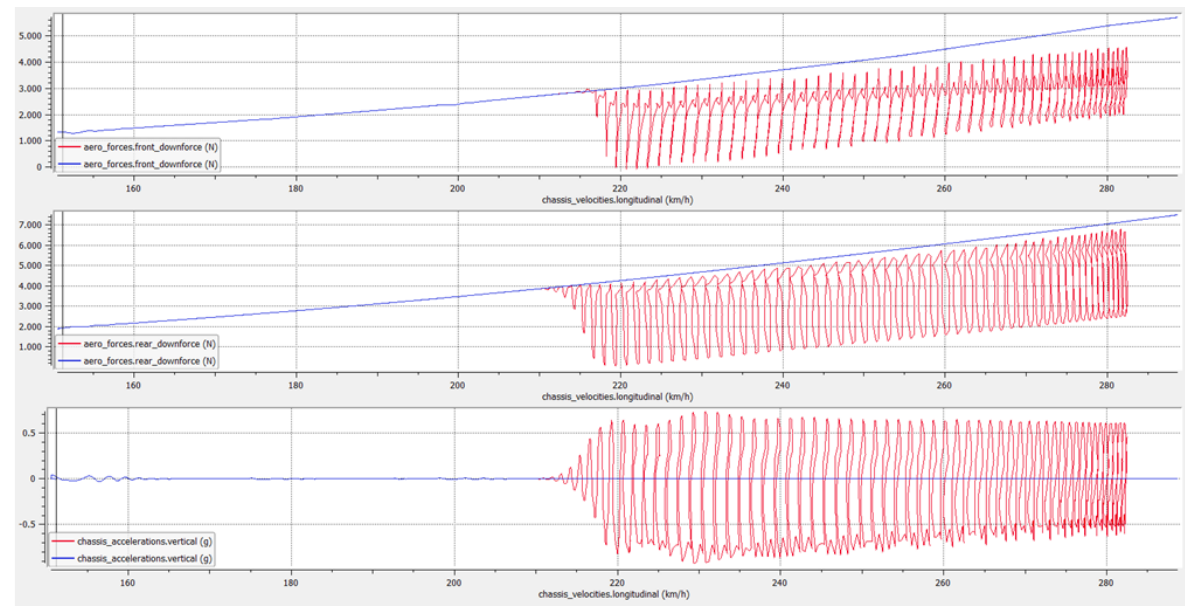
Figure 17. Comparison of aerodynamic vertical forces with baseline maps (blue) and with decay functions (red). Apart from the oscillations, the average downforce is massively reduced either at the front ( top plot) and at the rear ( middle plot). Vertical acceleration at the center of gravity ( bottom plot) oscillates with an amplitude of +/ − 0.6 g.